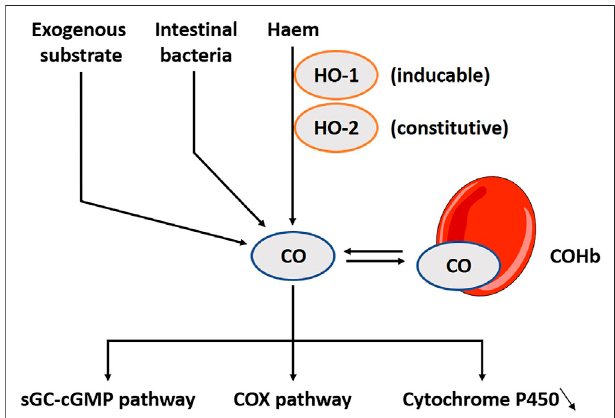
FIGURE 1 | The nitric oxide (NO) pathway including involved substrates, enzymes and downstream pathway. L -arginine amino acid is the substrate from which NO is generated by the enzyme NOS. Three different NOS-isoforms exist: neuronalNOS(nNOS),endothelialNOS(eNOS)andinducible(in fl ammatory) NOS (iNOS). In addition, several exogenous substrates exist to induce the NO- downstream pathway. L -NAME and LNMMA block NOS function. The biological functions of NO are related to the activation of sGC; subsequently in fl uencing cGMP. NOS, Nitric oxide synthase; L -NAME, N( ω )-nitro- L -arginine methyl ester;